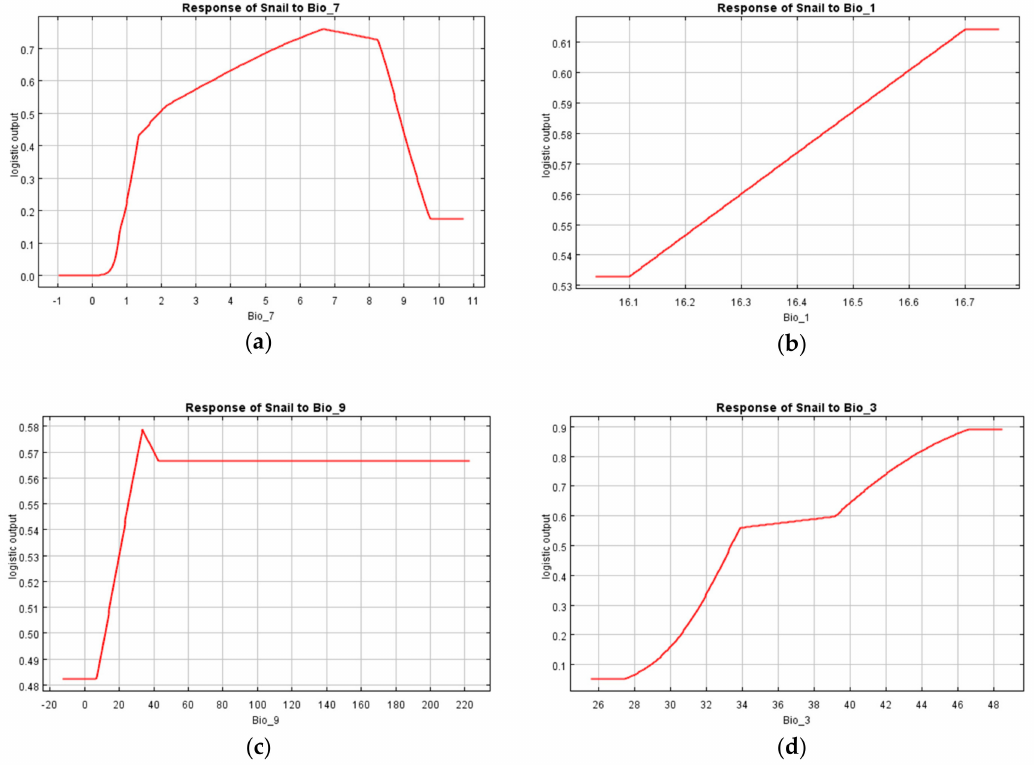
Figure 8. Response curves of the four major environment variables. The x-axis and y-axis represent the value of a factor and the probability of O. hupensis occurrence, respectively. Note: Bio_1, annual average temperature; Bio_3, humidity of the climate; Bio_7, ditch density; Bio_9, digital elevation model. ( a ) ditch density; ( b ) temperature; ( c ) digital elevation model; ( d ) humidity of the